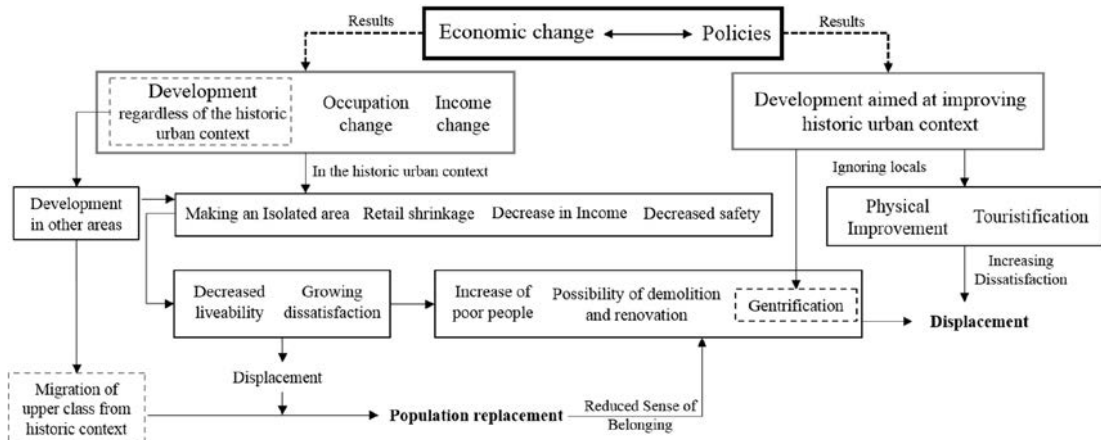
Fig. 7: The modality of interaction between economic change and policies on the relocation of historic urban context community